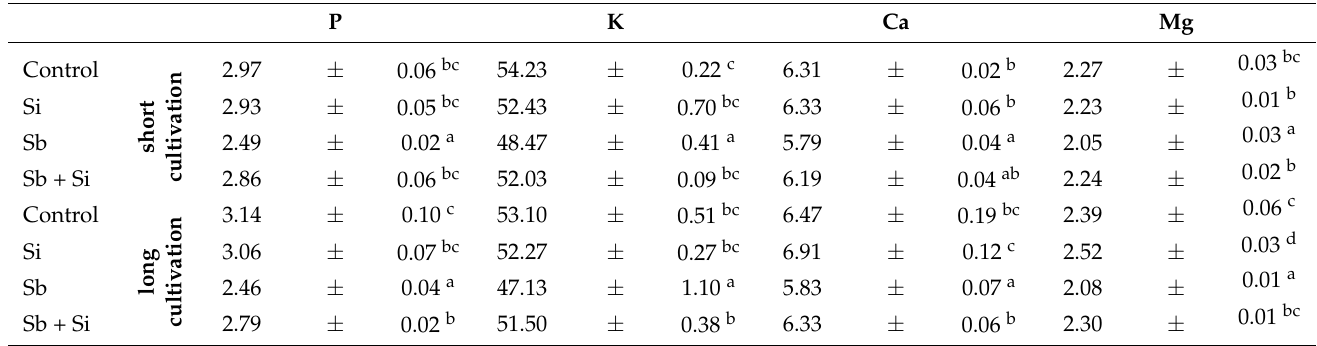
Table 2. Concentration of macronutrients (mg g − 1 dry mass) in the poplar calli after the short and long cultivations. The data are presented as the means ± standard error ( n = 3). Control—basal medium; Si treatment—basal medium + Si (5 mM); Sb treatment—basal medium + Sb (0.2 mM); Sb + Si treatment—basal medium + Sb (0.2 mM) and Si (5 mM). Different letters (a, b, c) denote statistically significant differences in the parameters between the treatments at p < 0.05 according to the Tukey test.